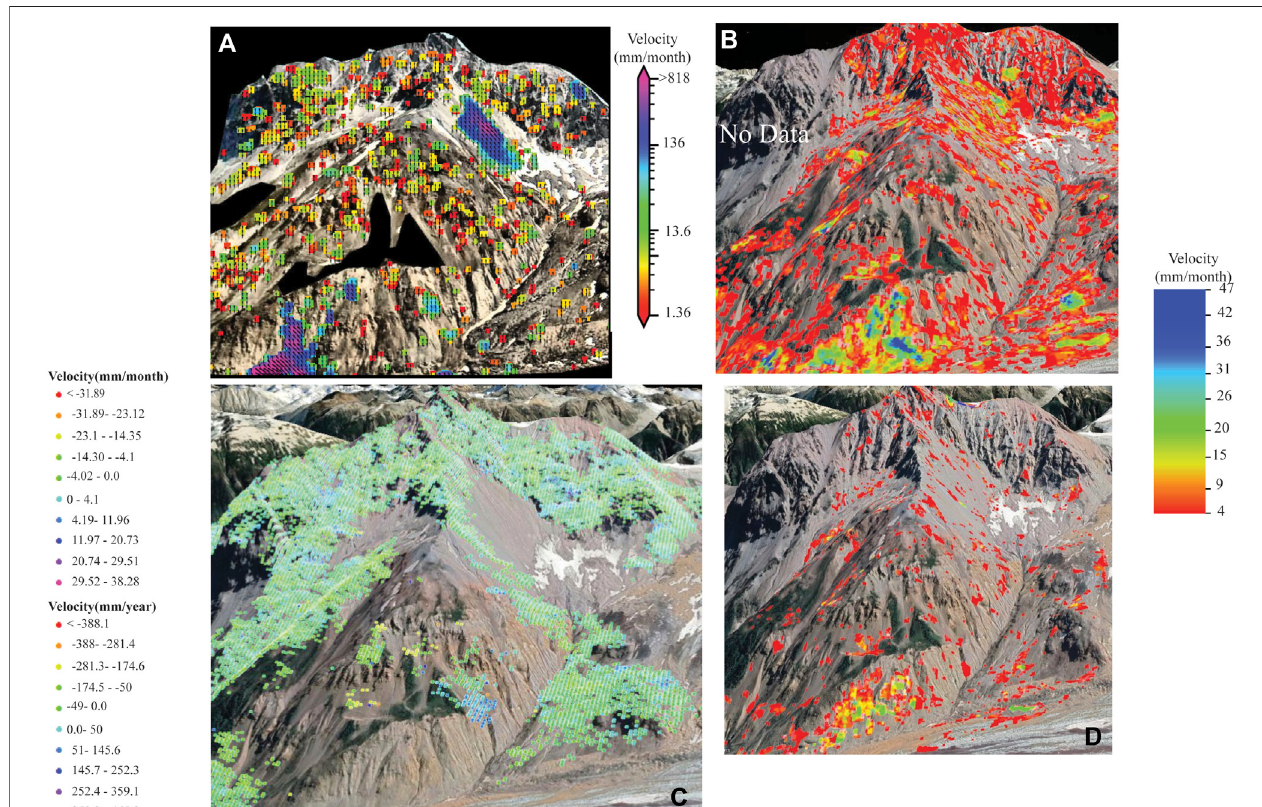
FIGURE15| Deformation ratesinmillimeter per month forPlinthPeakslope. (A) Deformationratecalculatedfrom ground-based optical imagesfrom July27to18 August 2021; note, the colour-bar is shown as a logarithmic scale, deformation rates larger than 20 mm represents traces of slow but continuous rockfalls within the processed timewindow period. (B) Deformationratecalculated fromorthorecti fi edoptical satelliteimages fromJuly28to13August2021,deformationmap processed with similarity threshold equal to 0.75. (C) Deformation rate calculated from radar images for summer 2019, 2020, and 2021 using TRE-ALTAMIRA SqueeSAR Software.SqueeSARbydefaultcalculateannualdeformationrate,werescaled toamonthlydeformationrate. (D) Deformationratecalculatedfromorthorecti fi edoptical satellite images from July 28 to 13 August 2021, deformation map processed with similarity threshold equal to 0.2.